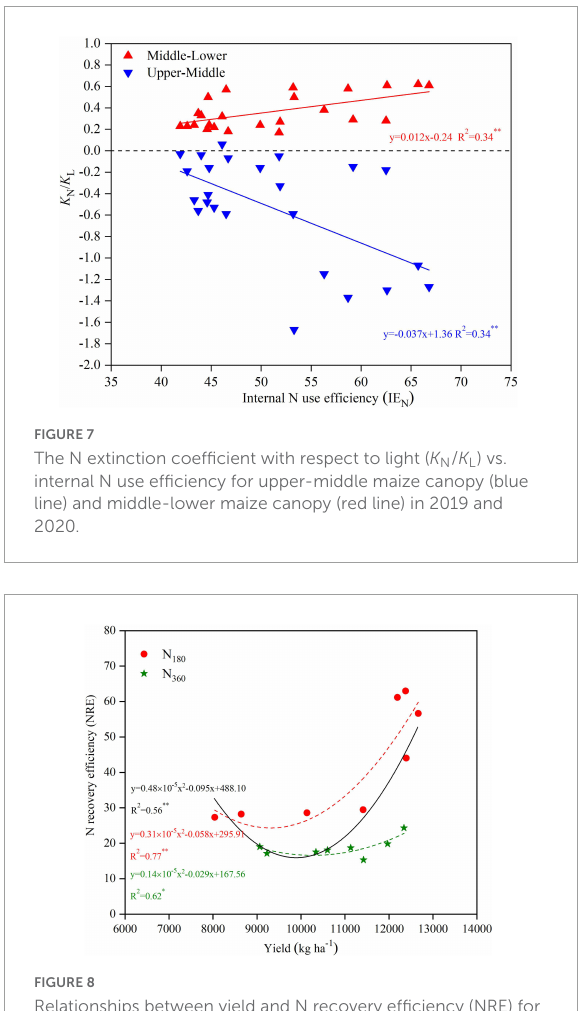
FIGURE8 Relationships between yield and N recovery efficiency (NRE) for maize in 2019 and 2020. Non-linear regressions were fitted for overall data (black solid line), data for the N 180 inputs (red dashed line) and N 360 inputs (green dashed line).